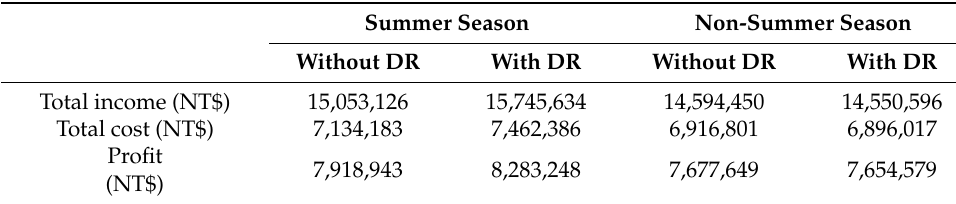
Figure 9. The daily profit of the VPP in the summer and non-summer seasons. Table 2. The total income and total cost of the VPP in the daily dispatch.